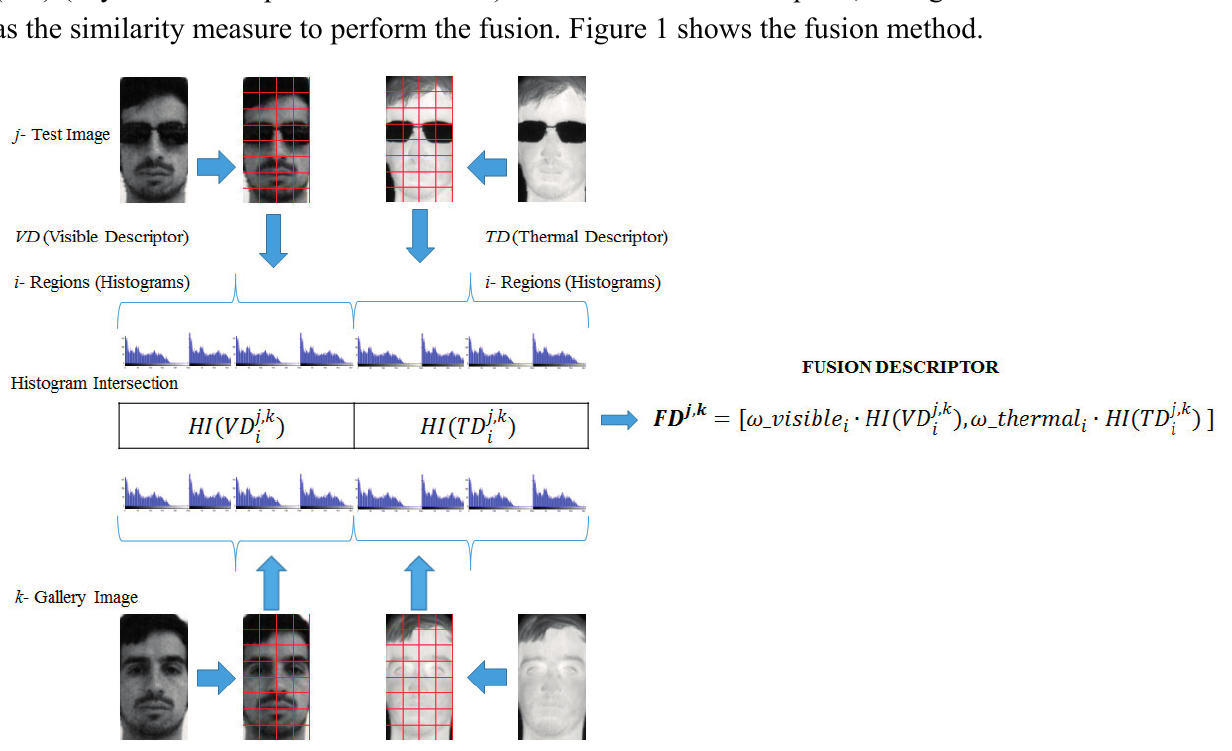
Figure 1. Fusion scheme